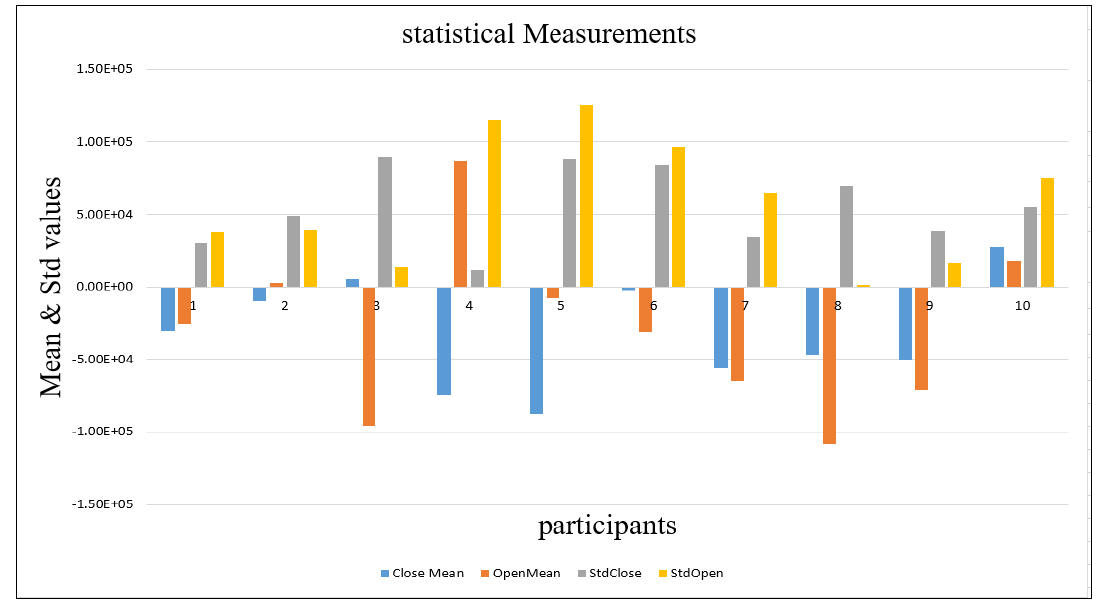
Fig. 5. The mean and standard deviation of 8 channels.